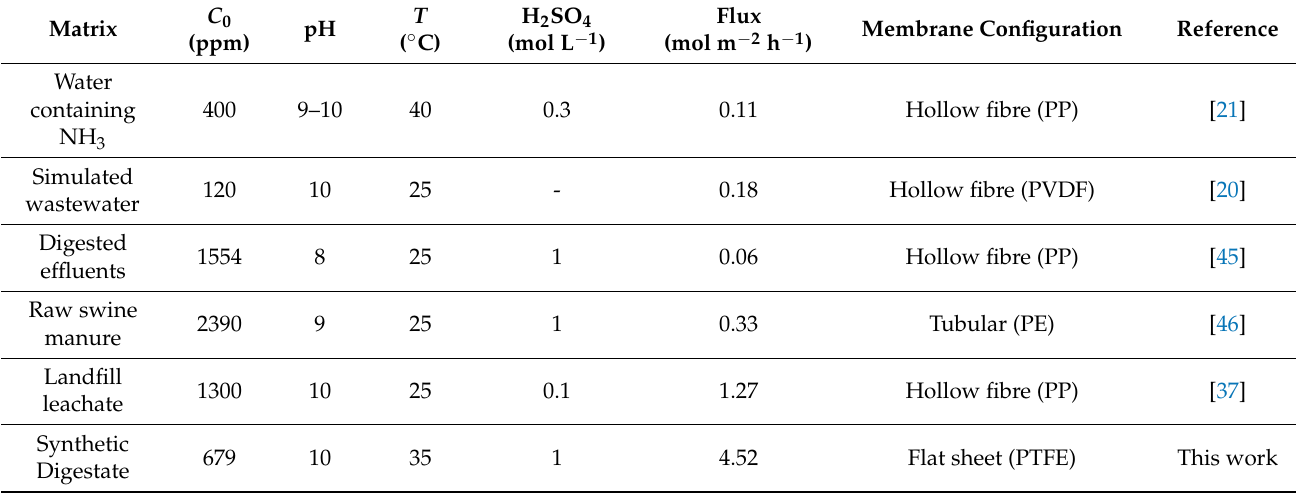
Table 3. Summary of fluxes using hydrophobic membranes.